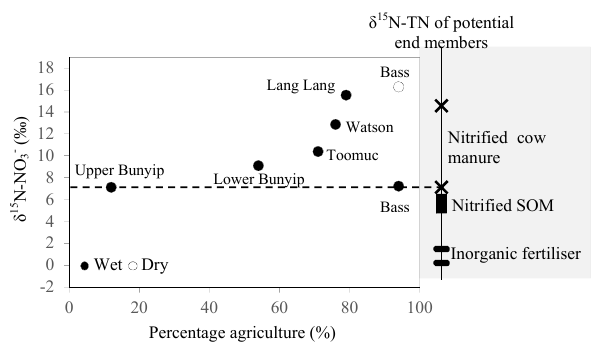
Figure 7. Relationship between δ 15 N–NO − of the dominant initial 3 source (indicated by the y -intercept of the Keeling plots; Fig. 6) and percentage agriculture during wet periods. Data for the Bass-dry pe- riod were also presented because only the Keeling plot for the Bass- dry period indicates mixing between different sources. The shaded area represents the δ 15 N–NO − of the potential end 3